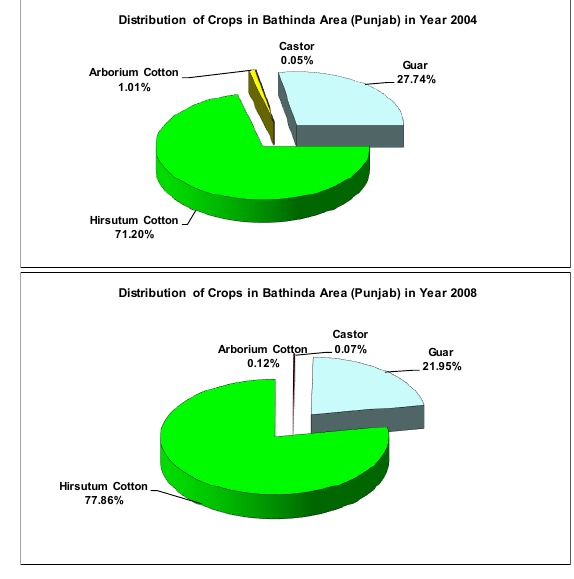
Figure-6. Distribution of Cotton and other crops in Bathinda during 2004 and 2008